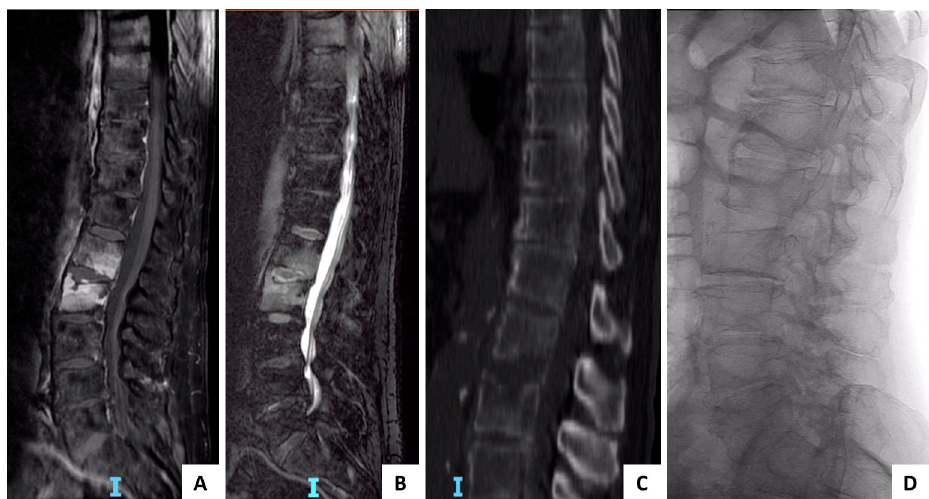
Figure 1. ( A – D ) Case example of L1–L2 pyogenic spondylodiscitis presenting without low back